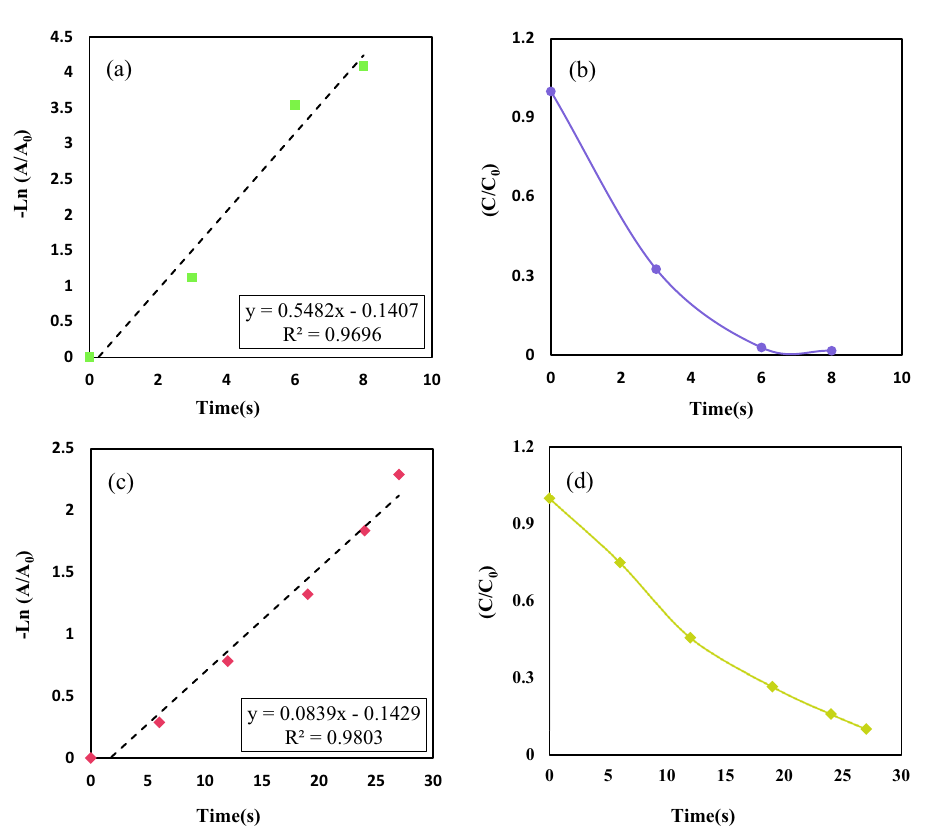
A t Figure 14. Plots of − ln ( A 0 ) vs time for the reduction reaction of ( a , b ) o-nitroaniline to ortho- PDA, ( c , d ) p-nitroaniline to para- PDA using prepared nanocatalyst.